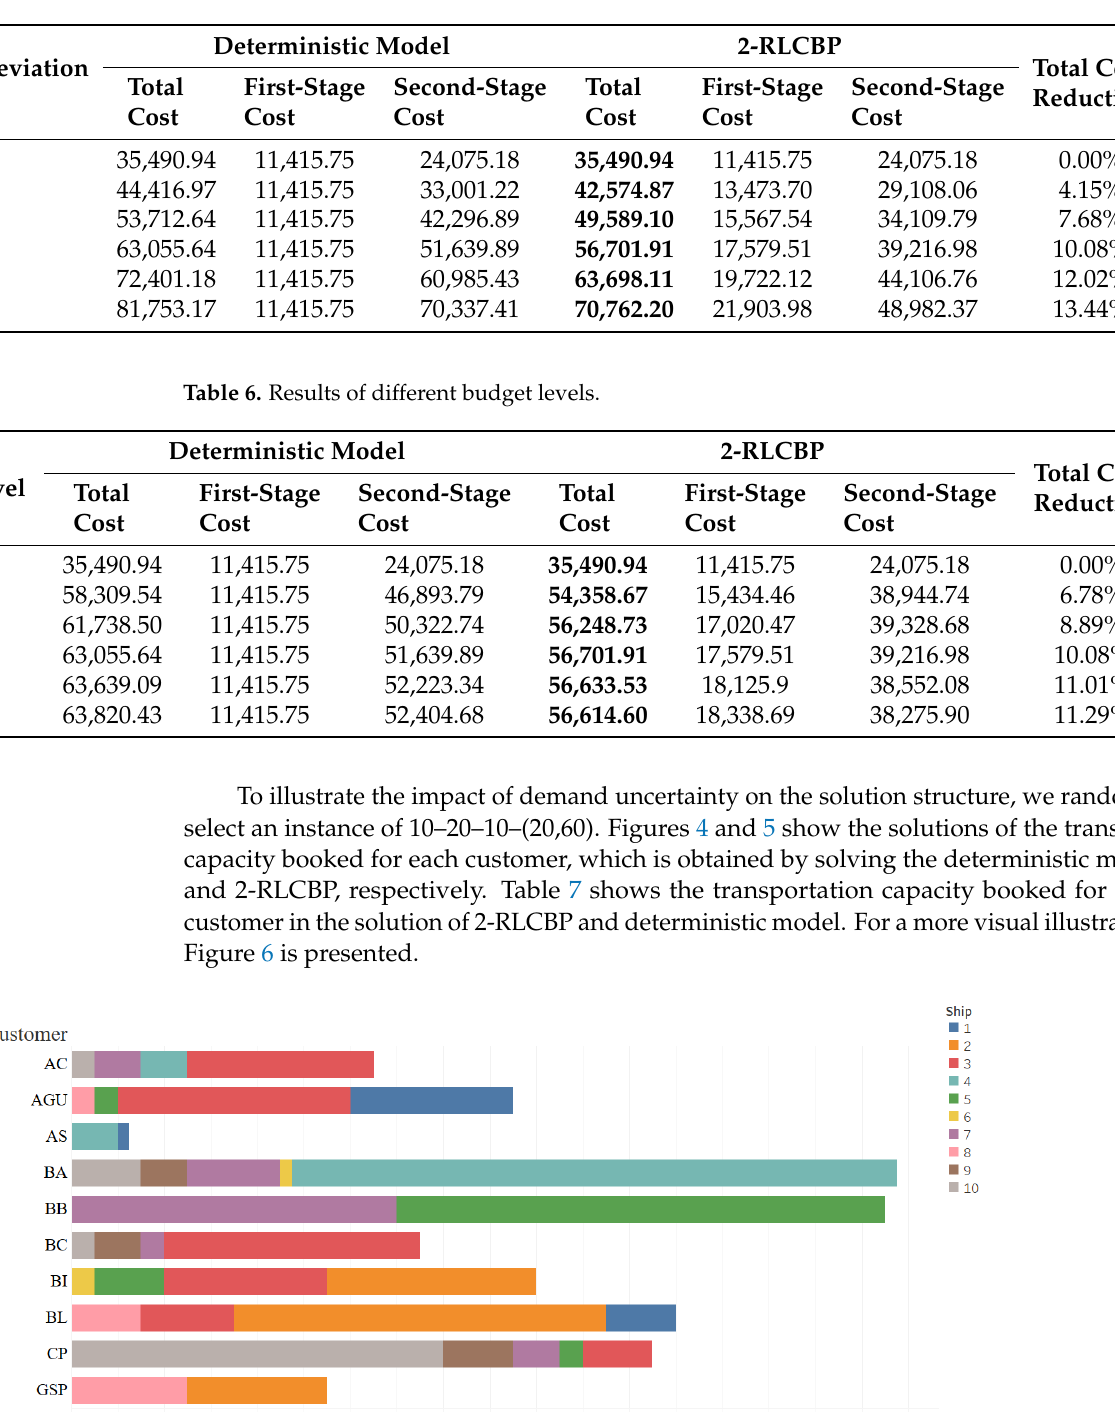
Table 5. Results of the different demand deviation levels.